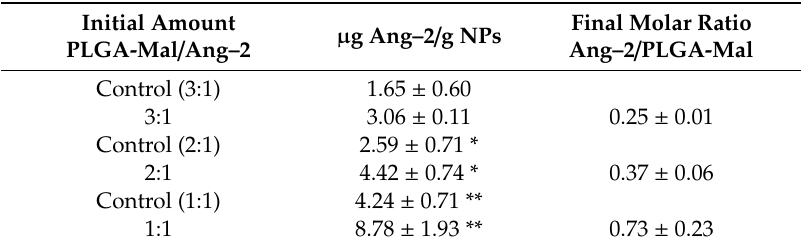
Table 1. Amount of Ang–2 bound to the nanoparticles determined through HPLC for three di ff erent PLGA-Mal / Ang–2 ratios. The controls correspond to nanoparticles with the same amount of Ang–2 as the experiment, but without the presence of PLGA-Mal. Values represent mean ± standard deviation ( n = 3experiments). *and**showstatisticallysignificantdi ff erences( P < 0.05)betweenthelabelsamples.